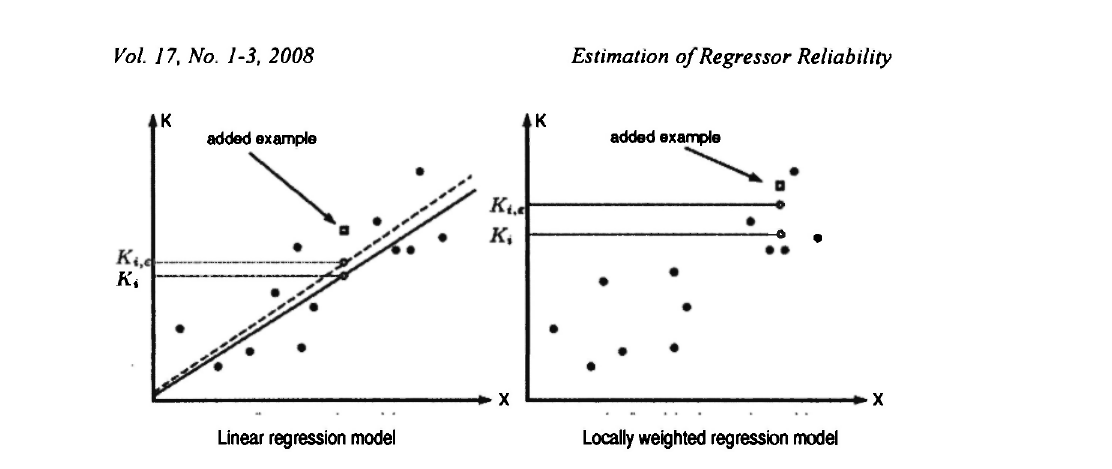
Fig. 2: The influence of the example with the increased initial label in a two- dimensional problem space (X is the only attribute). Both figures show a new learning example that was added to the learning set (depicted with an empty square). Before addition, the increased label (1) is assigned to the example (ε > 0). The initial and the resulting trans-ductive predictions are marked with white circles. Left: The new learning example causes transductive linear regression predictor (depicted with the intersected line) to increase predictions for all values of X with respect to the initial predictor (depicted with the full line). Right: The new learning example is the nearest neighbor of the predicted example (they have the same value of X). As the label of the added example is higher than K, , the influence of the added example results in making an increased prediction K le in comparison with the initial prediction